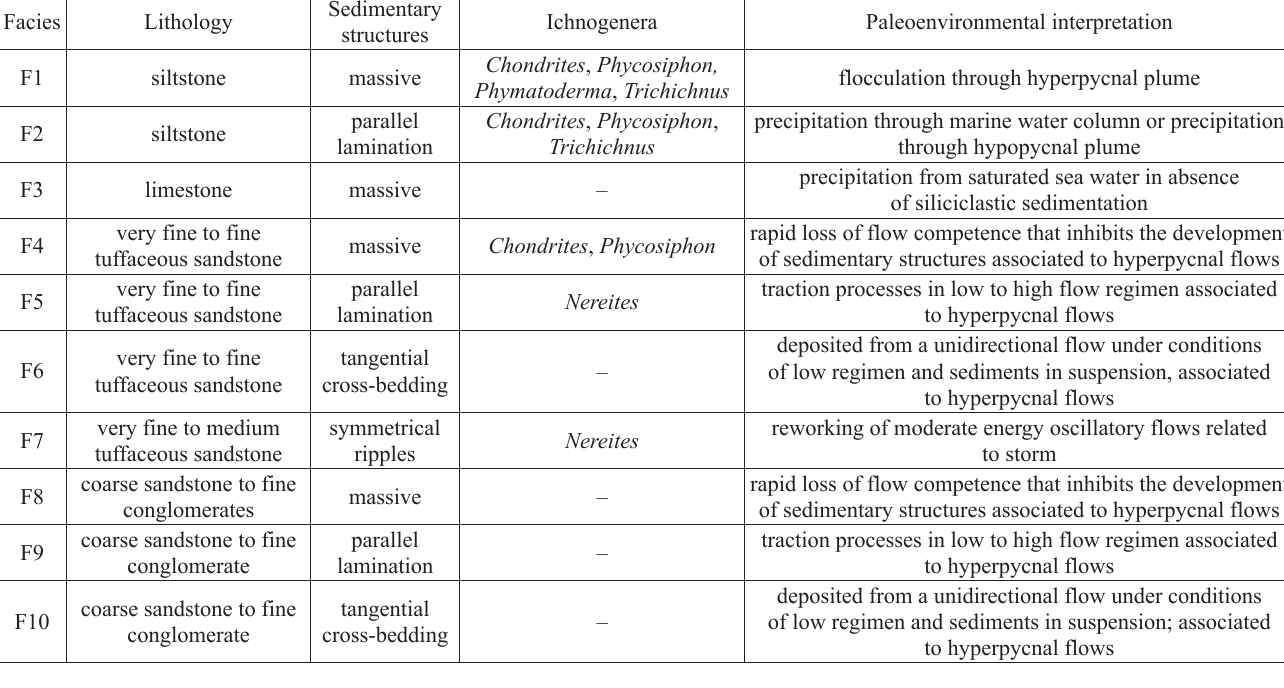
Fig. 2. Outcrop characteristics of the Sierra Chacaicó section. A . Panoramic view of the prograding clinoforms of Gilbert-type delta affected by hyper- pycnal discharge in Sierra Chacaicó Formation at Arroyo Lapa locality. B . Levels of tuffaceous sandstone facies with phytodetritus towards the top (ar- rows). C . Chondrites intricatus Brongniart, 1823 ( Ch ) in massive siltstone. D . Trichichnus isp. ( Tr ) at the top of very fine massive tuffaceous sandstone. E . View in section of Phycosiphon incertum Fischer-Ooster, 1858 ( Ph ) in very fine massive tuffaceous sandstone. F . View in section of Phymatoderma isp. ( Phm ) in massive siltstone. G . Nereites isp. ( Ne ) at the top of medium tuffaceous